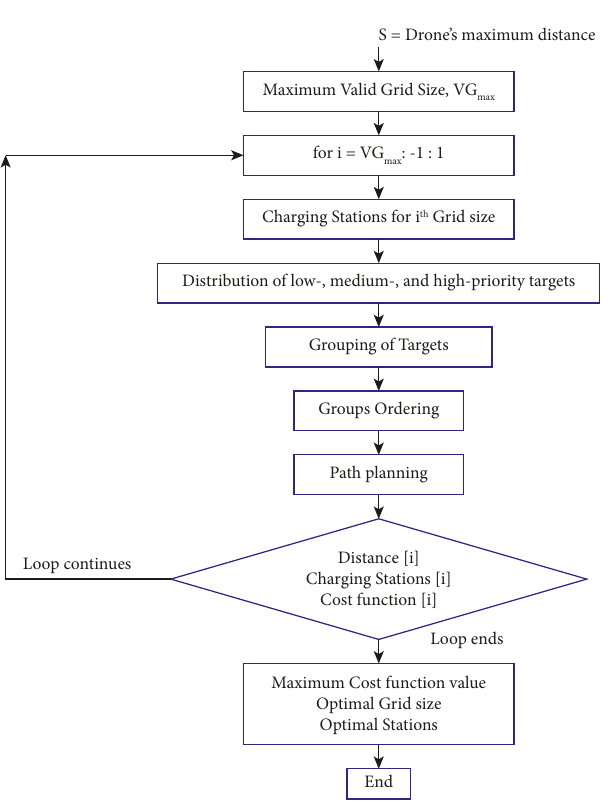
Figure 3: Flow chart of the proposed algorithm for determining the optimal number of charging